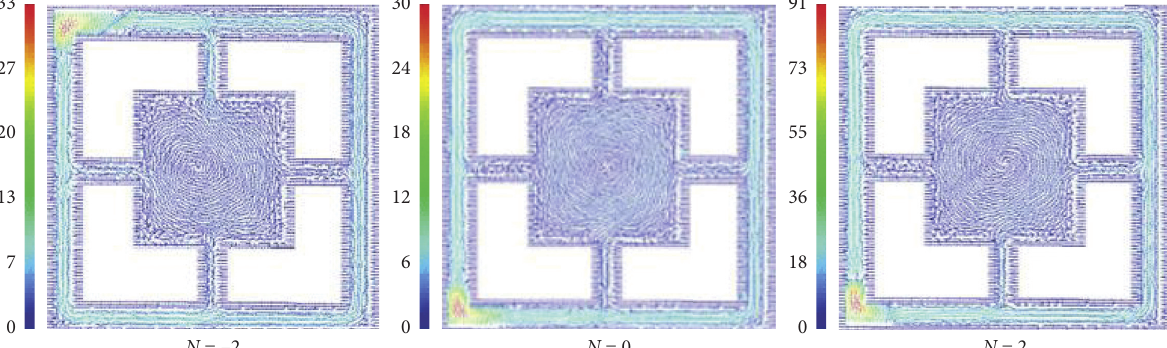
Figure 5: Velocity field below the variations of a buoyancy ratio parameter at Ra � 10 4 , ϕ � 0 . 01 , Da � 10 − 3 , η and τ � 1.